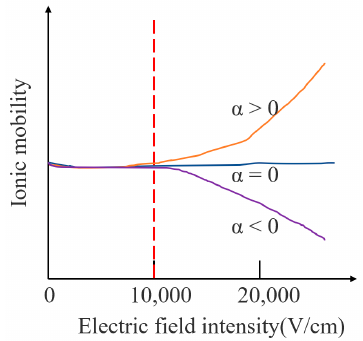
Figure 1. Variation of ion mobility under different electric field conditions.